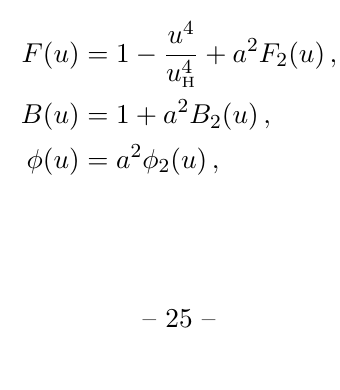
), whereas the dashed curves represent the H ). Here we have (cid:12)xed u = H H